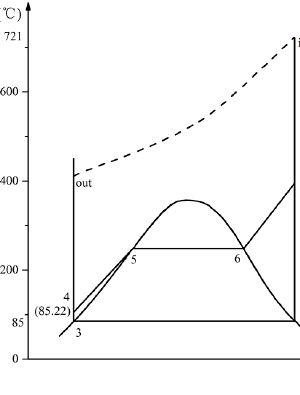
Figure 3. Rankine cycle T-S diagram for Case 1.